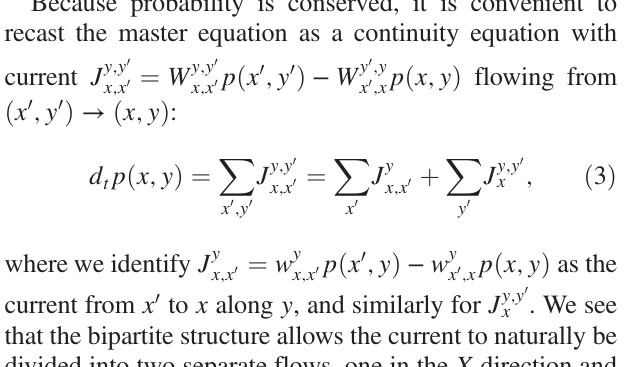
FIG. 1. Construction of a bipartite graph: A system X , with two states x 1 and x 2 (teal dots), linked by one transition (dashed teal horizontal line), is coupled to an independent system Y that jumps between two states y 1 and y 2 (purple dots) through two mecha- nisms (purple vertical lines). The resulting composite system has four states and is bipartite, since no diagonal edges corresponding to new transition mechanisms are added by the